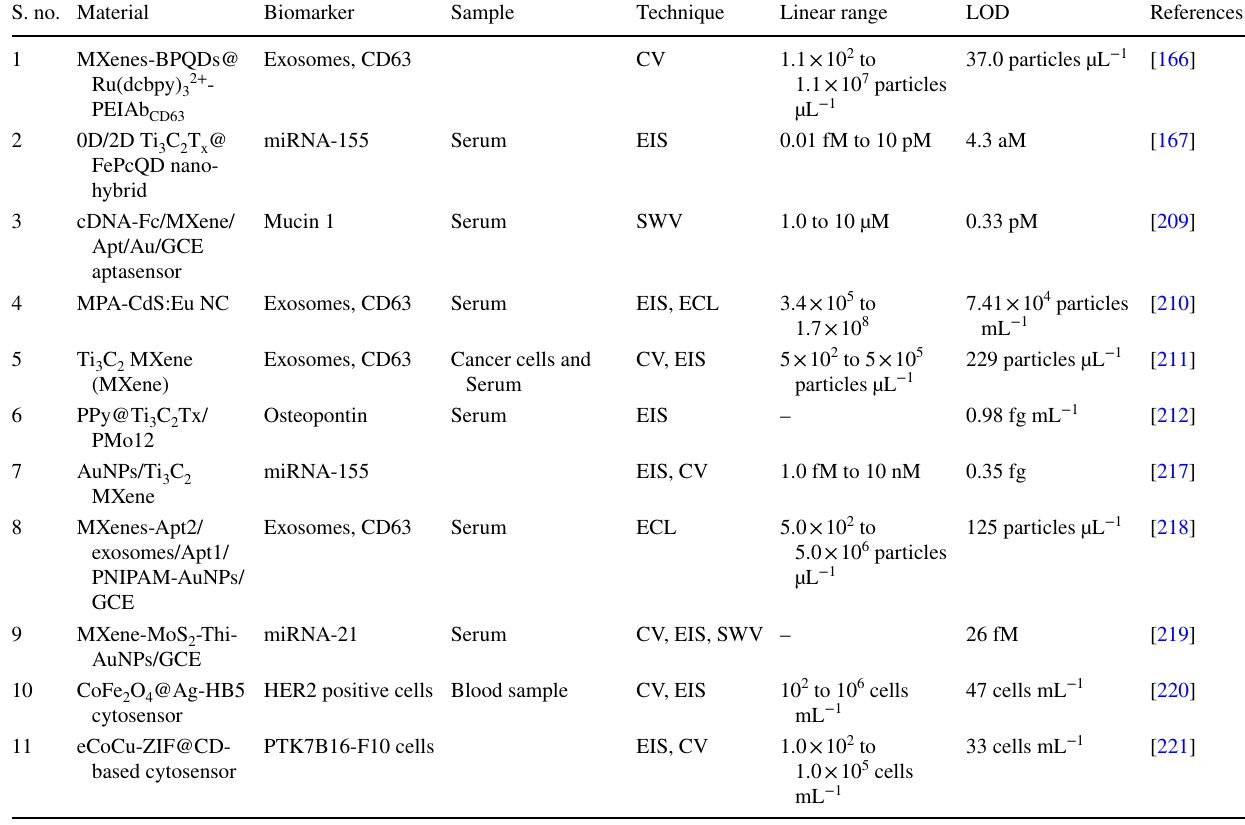
Table 2 MXene-based electrochemical aptasensors for cancer diagnosis (sensitivity and detection limit) S. no.